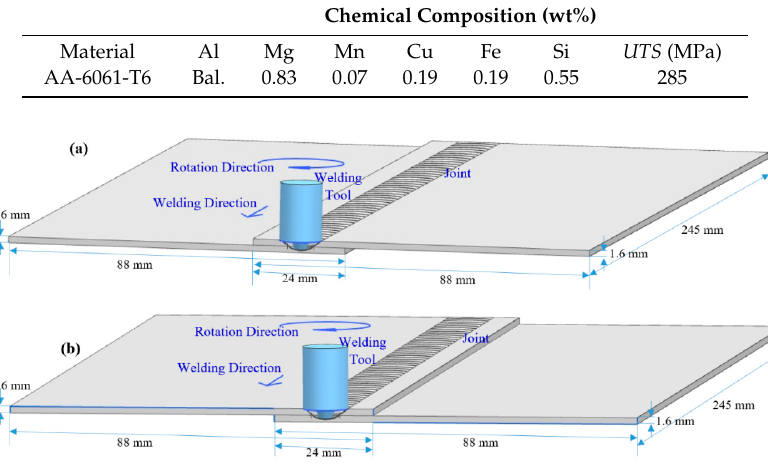
Figure 2. The schematic of the welding process for two possible configurations of the lap joints; ( a ) the top sheet on the right side (configuration 1); ( b ) the top sheet on the left side (configuration 2).